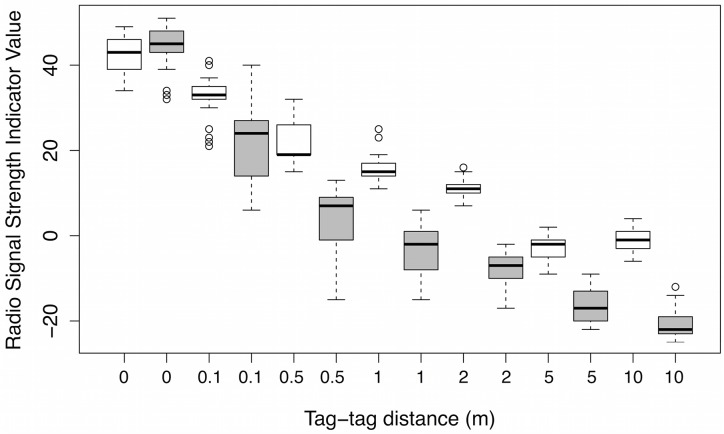
Received signal strength indicator (RSSI) values recorded between 11 tag pairs across seven different tag-tag distances.Two tag antenna orientations (parallel = white boxes, perpendicular = gray boxes) were tested for each distance and three RSSI values were recorded for each antenna orientation.